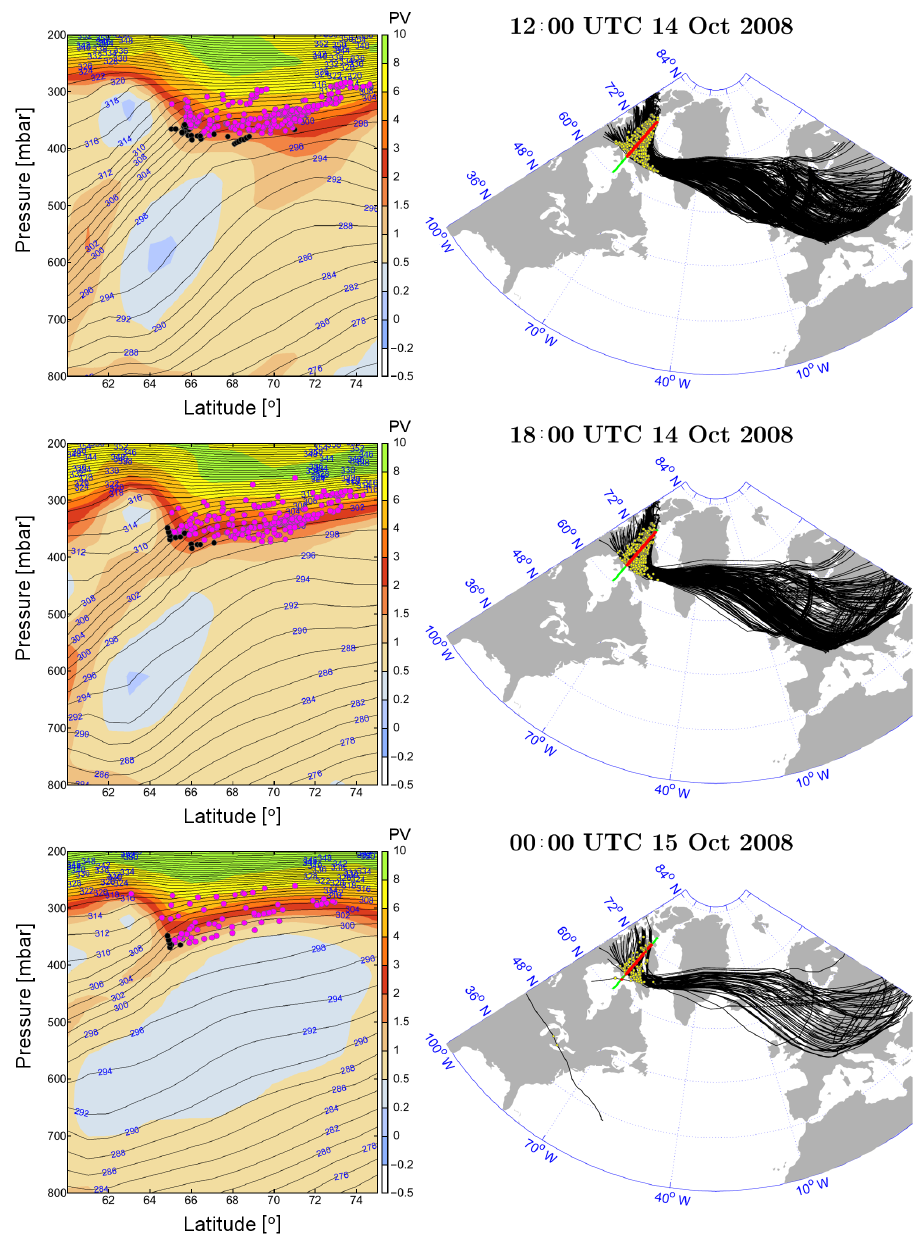
Figure 13. Right panels: intrusion trajectories (black lines) intersecting a vertical control surface (green line) above northern Canada at three different times; left panels: intersection points of the trajectories on the control surface (see text); the blue contour lines are isentropes (in